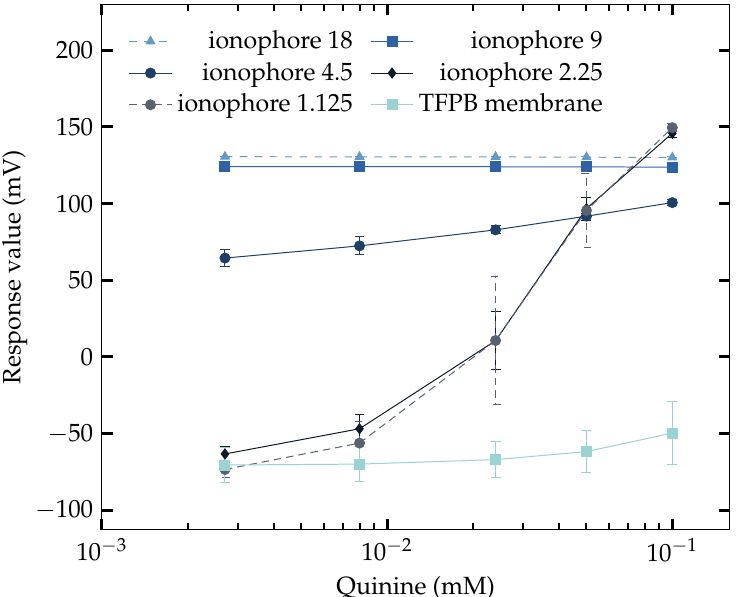
Figure 3. Responses of NaISE of different Na + ionophore concentrations to NaCl (70 mM) + quinine